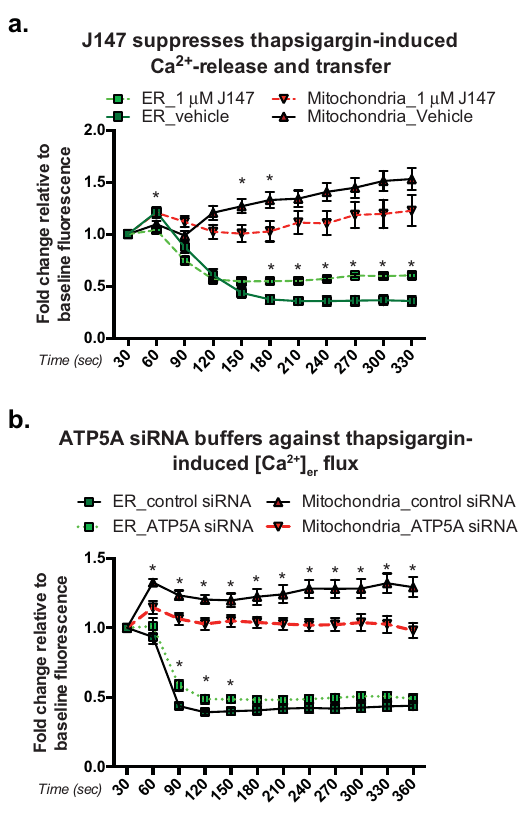
Fig. 4 J147 and ATP synthase knockdown buffer against ER Ca 2 + release and transfer to mitochondria. HT22 cells treated with 1 μ M J147 or ATP5A siRNA transfection were co-transfected with ER and mitochondrial-speci fi c fl uorescent Ca 2 + sensors to monitor changes in fl uorescence via Z -stack confocal microscopy live-cell imaging ( a ) after 5 μ M thapsigargin treatment in Ca 2 + -free media. Baseline fl uorescence was recorded for 30 s before addition of thapsigargin. Fold changes in fl uorescence for J147 ( a ) and ATP5A siRNA ( b ) were recorded at 30 s intervals and normalized to baseline fl uorescence intensity for each condition in each treatment group. The Ca 2 + sensors are ER (green) and mitochondria (red). Multiple t -test (Holm – Sidak method); n = 21 and 25 cells examined in a and b , respectively . *p < 0.05; scale bar = 10 μ